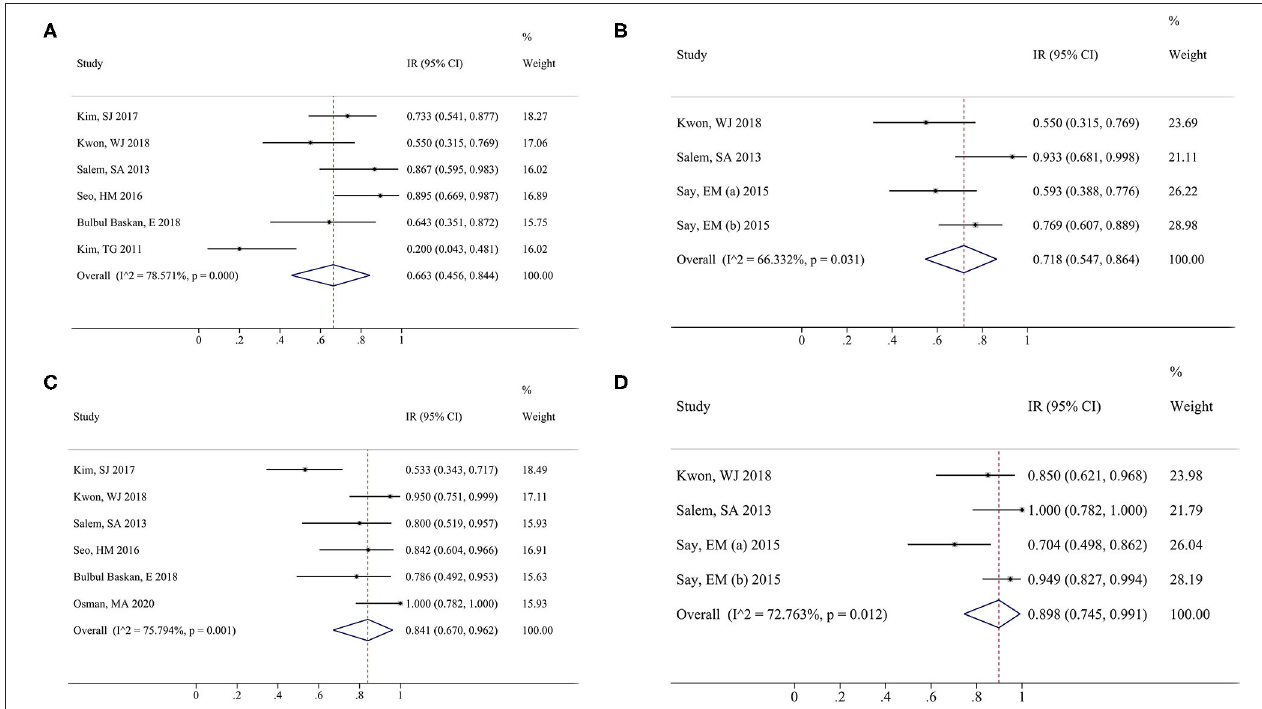
FIGURE 3 | Forest plot of overall risk ratios of physicians’ clinical assessment (PCA) and patient global assessment (PGA) in the pulsed dye laser (PDL) group vs. neodymium:yttrium-aluminum-garnet (Nd:YAG) groups. PCA of PDL group (A) and Nd:YAG group (B) ; PGA of PDL group (C) and Nd:YAG group (D) . Squares indicate the estimates for the corresponding study; the size of the square is proportional to the weight of the study to the overall estimate. Diamonds indicate an overall pooled estimate while horizontal lines represent the 95% CI. PDL, pulsed dye laser; Nd:YAG, neodymium:yttrium-aluminum-garnet.